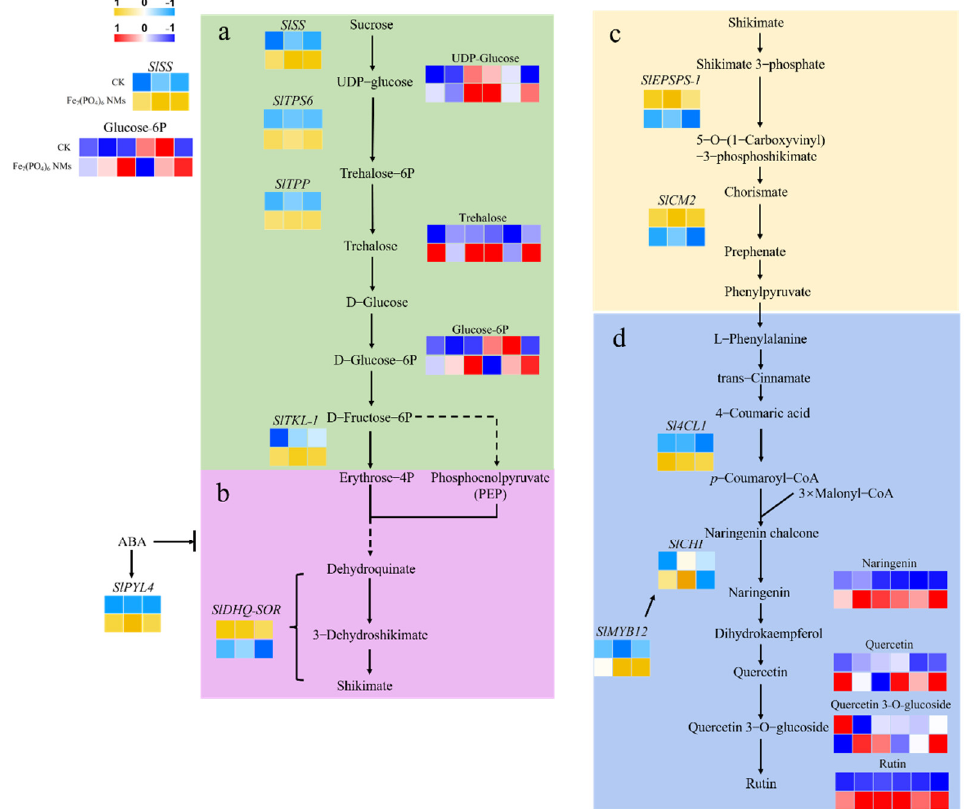
Figure 8. Transcriptomic and metabolomic pathways of flavonoids synthesis enhanced by Fe 7 (PO 4 ) 6 NMs in tomato fruits. ( a ) sucrose metabolism; ( b ) shikimic acid pathway; ( c ) phenylalanine synthesis pathway; ( d ) flavonoid biosynthesis pathway. The data of transcriptomics and metabolomics were normalized before comparison in heatmaps. The color scheme represents decrease or increase of value of log 2 (fold change) and the fold change indicated the FPKM ratio of DEG and response value ratio of DEM in 50 mg kg −1 NMs to control. At transcriptional level, blue represents downregulation and yellow means upregulation; at metabolic level, blue represents downregulation and red means upregulation. Upper squares represent samples of CK and lower ones represent samples of NMs.